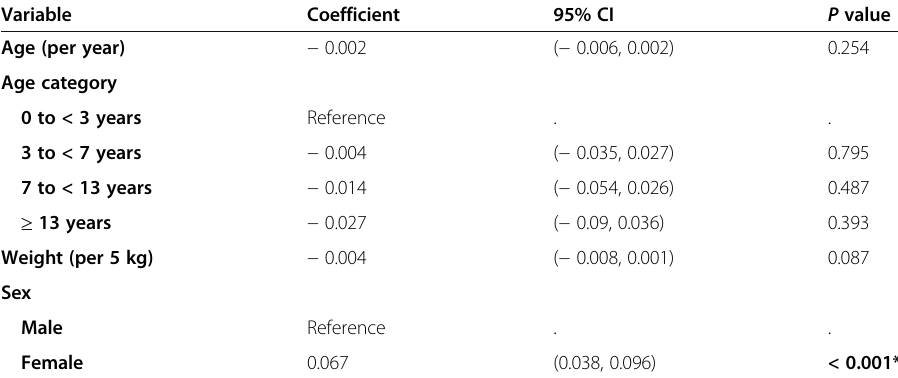
Table 3 Univariate median regression analysis of kidney activity fraction